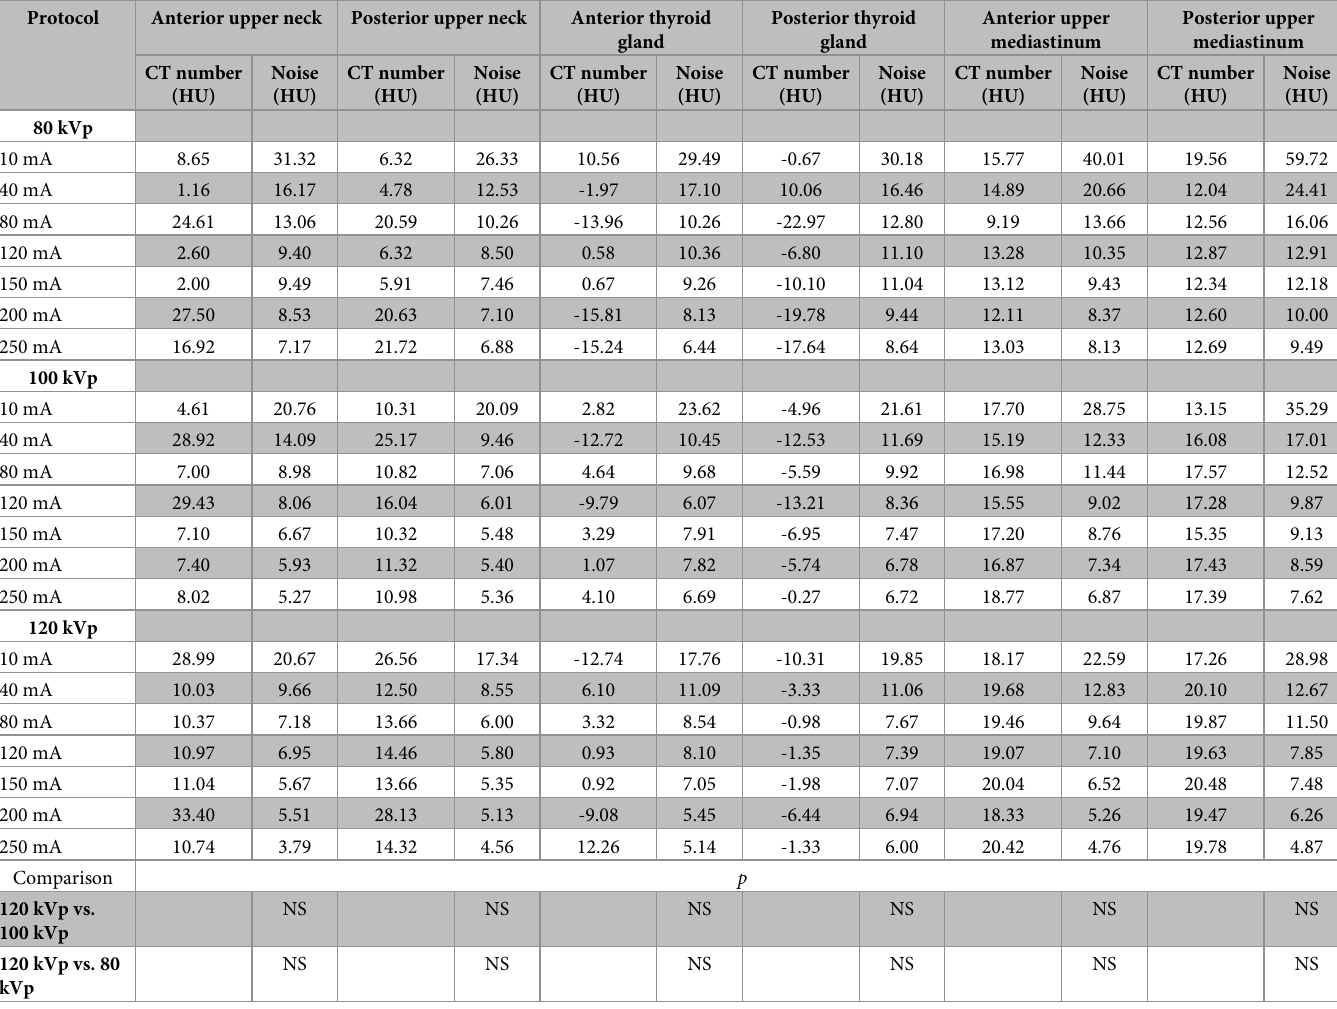
Table 2. Results of objective analyses of reconstruction techniques for computed tomography imaging of simulated neck scans of a child aged 1 years. Protocol Anterior upper neck